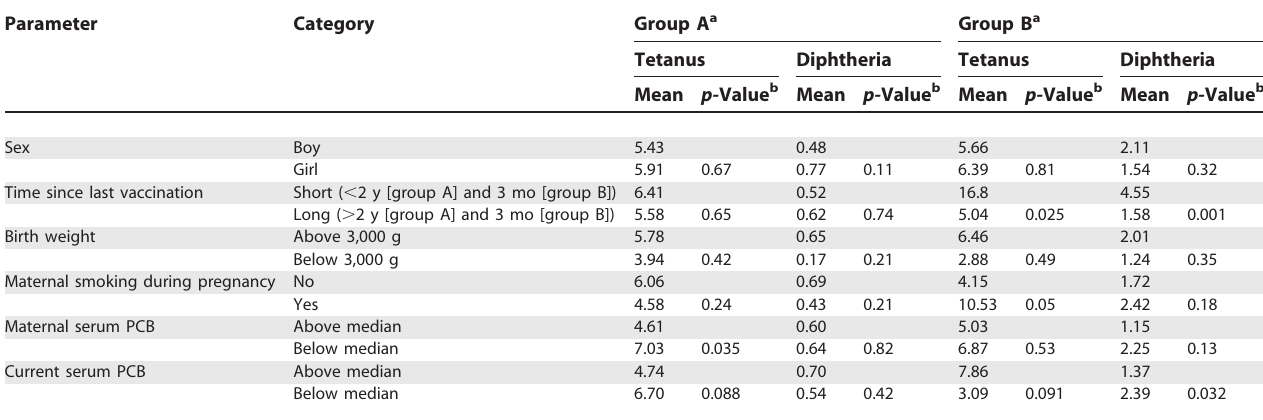
Table 2. Concentrations of Serum-Specific Antibody against Tetanus and Diphtheria Toxoids in Relation to Possible Predictors